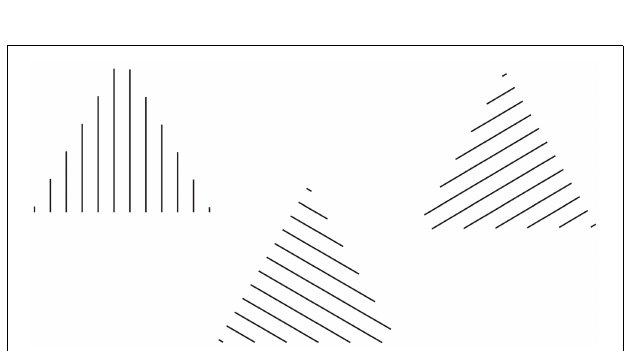
FIGURE 13 | The equilateral triangles are perceived pointing in different directions on the basis of the orientation of the lines.